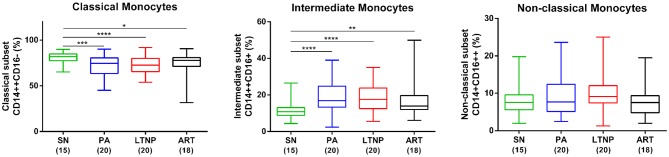
Altered frequencies of monocyte subsets in HIV infection. Box and whisker plots showing comparison of frequency of monocyte subsets in PA (n = 20), LTNP (n = 20), and ART (n = 18) groups with seronegative controls (SN, n = 15) (horizontal bar indicates median). Statistical significance was estimated by Kruskal-Wallis ANOVA followed by Dunn's multiple comparison test; *P < 0.05; **P < 0.01; ***P < 0.001; ****P < 0.0001. The expansion of non-classical subset (right-most panel) in ART-naïve groups was not significant by ANOVA but was observed to be significantly higher in LTNPs compared to both SN and ART groups by unpaired t-test (P < 0.05 for both).